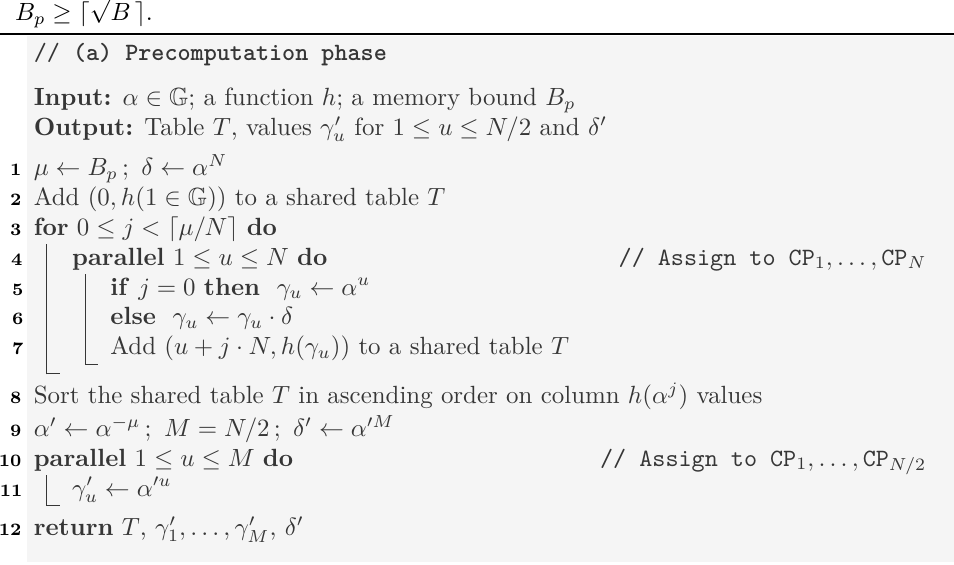
and (b) the on-the-fly p